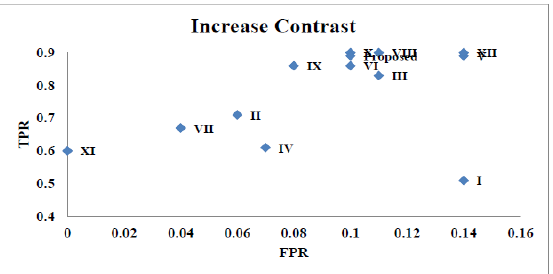
Figure 13. TPR vs. FPR: Increase 295